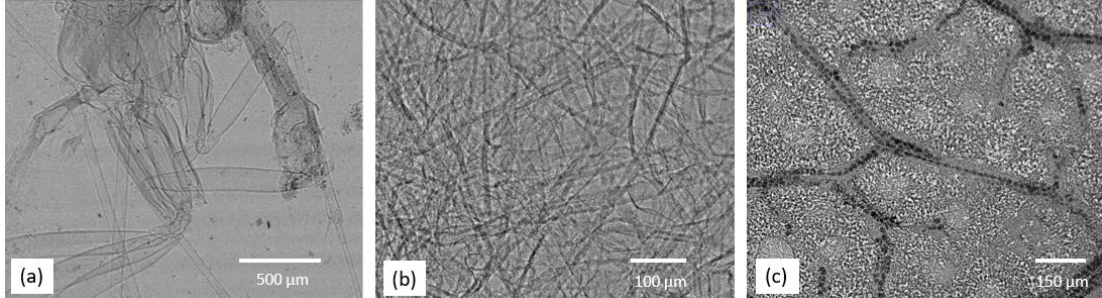
Figure 7. X-ray phase-contrast images (at 11 keV monochromatic beam collected using 5× objective lens): ( a ) an insect, ( b ) fibrous paper, and ( c ) a eucalyptus leaf. lens): ( a ) an insect, ( b ) fibrous paper, and ( c ) a eucalyptus